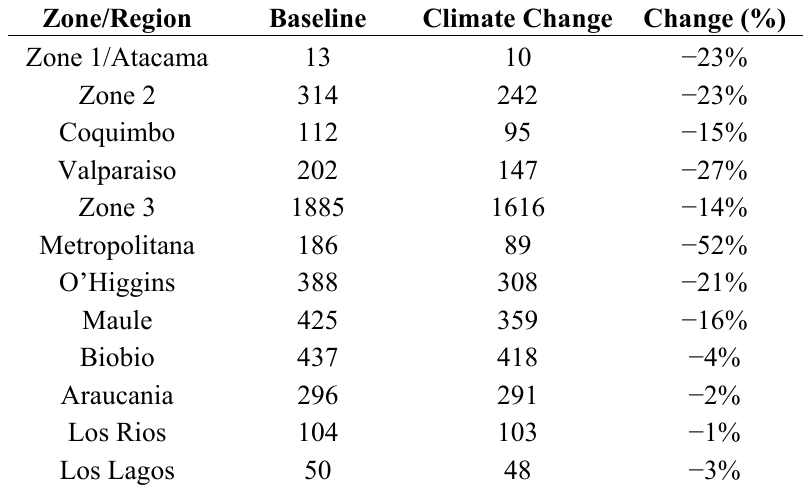
Table 4. Expected Changes in Agricultural Net Income (Million